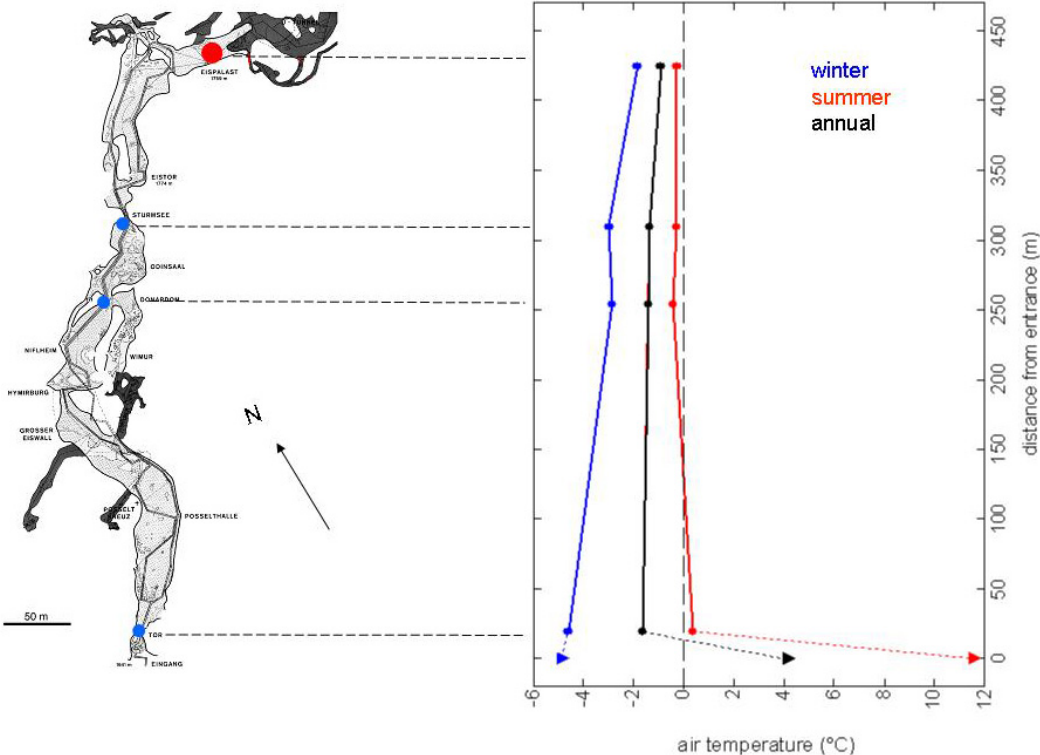
Fig. 2. Plan view of the ice-bearing part (light grey) of Eisriesenwelt (left) and seasonal average temperatures along this transect (1 December 2006 until 30 November 2007). Dots denote long-term temperature measurement sites within the cave, triangles denoting air temperature outside the cave (Feuerkogel,